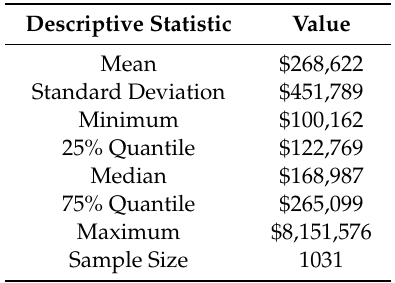
Table 1. Summary statistics for total incurred amount of claims.